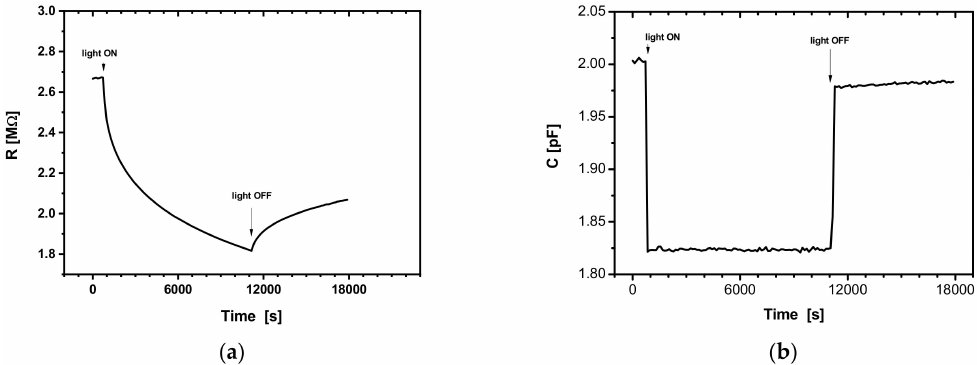
Figure 6. ( a ) R (t) at U DC = 0 V, with light off-on-off; ( b ) C (t) at U DC = 0 V, with light